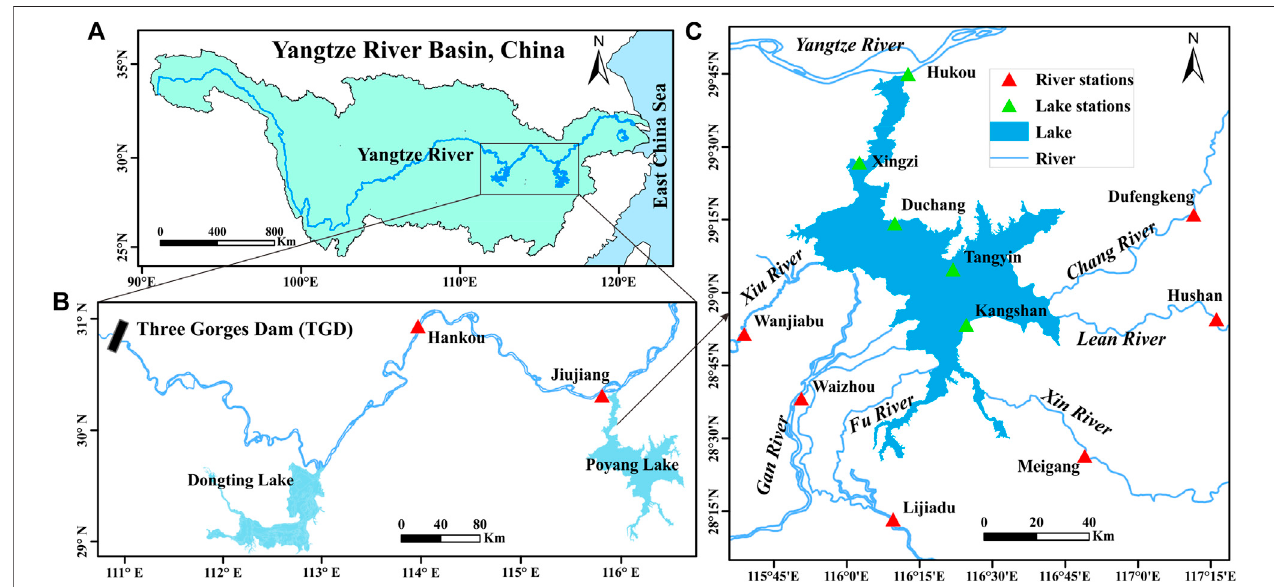
FIGURE 1 | Sketch map of study area. (A) location of Poyang Lake in the Yangtze River basin, (B) location of Poyang Lake and the Three Gorges Dam and (C) related hydrological stations in Poyang Lake region.